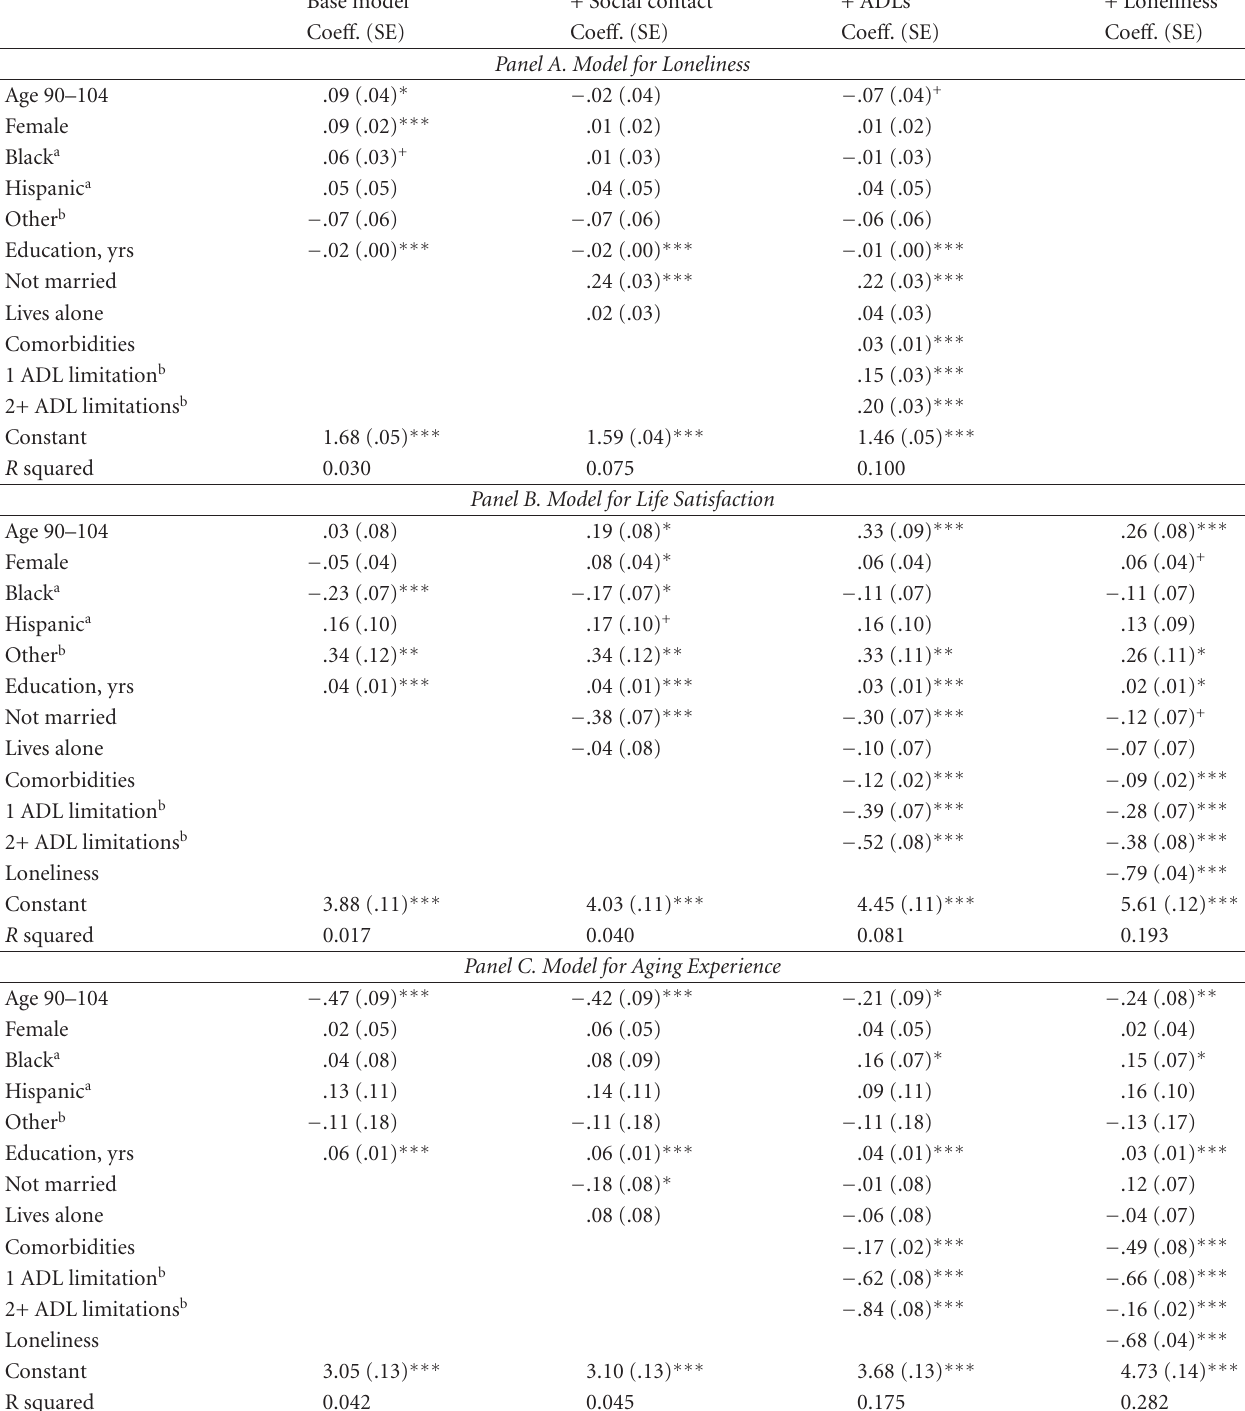
Table 6: OLS regression models for loneliness, life satisfaction, and perceptions of the aging experience. Base model